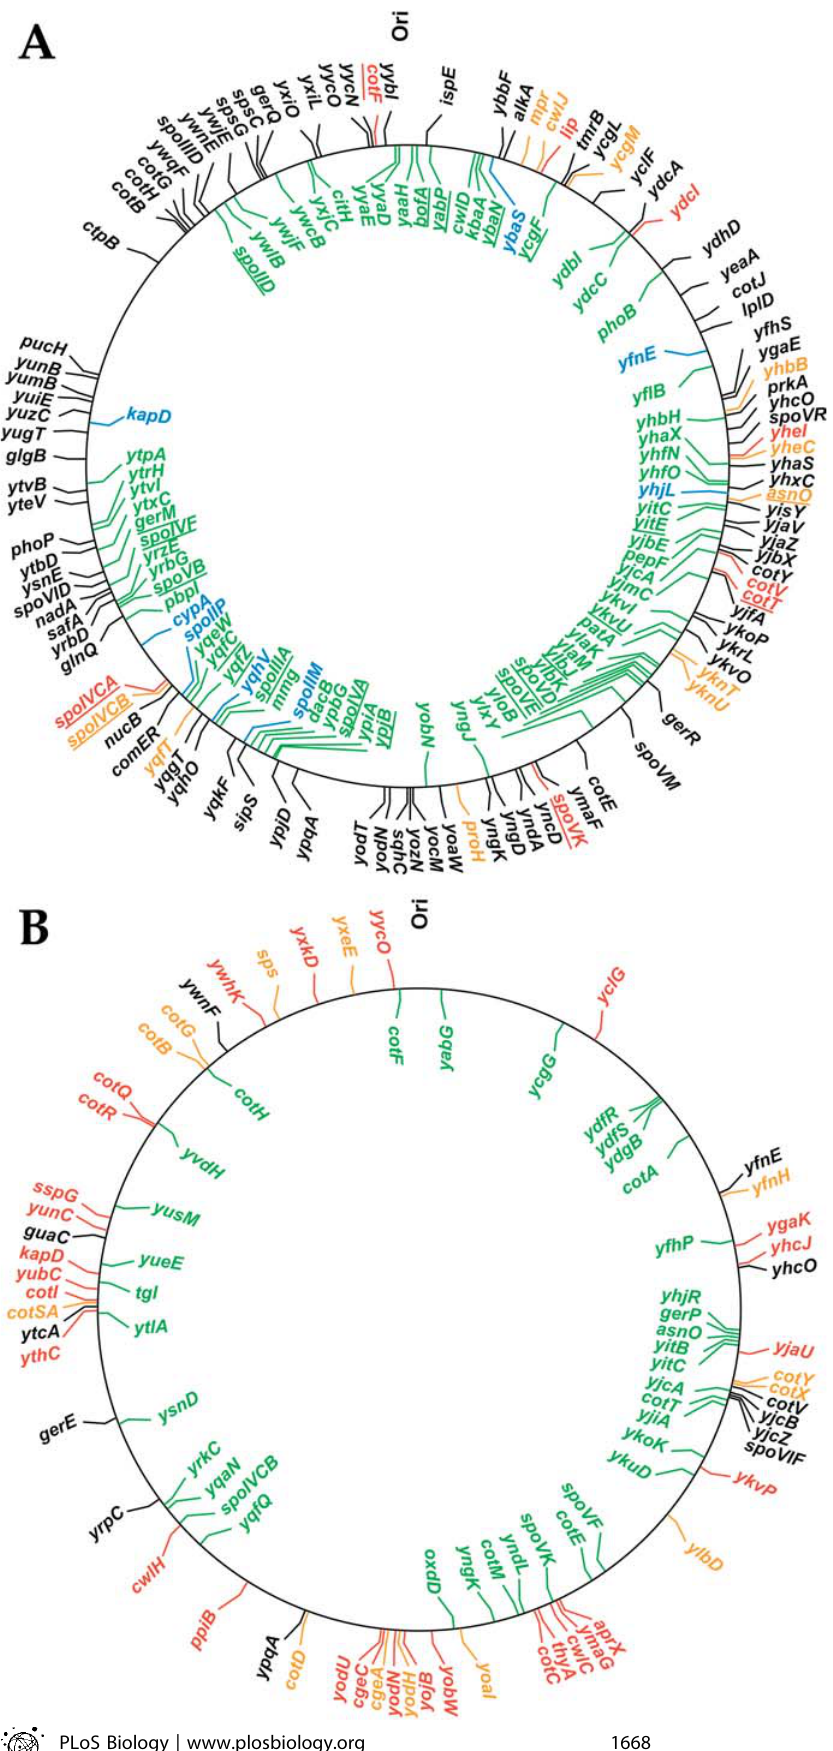
Figure 2. Location of Genes in the r E and r K Regulons and Their Regulation by DNA- Binding